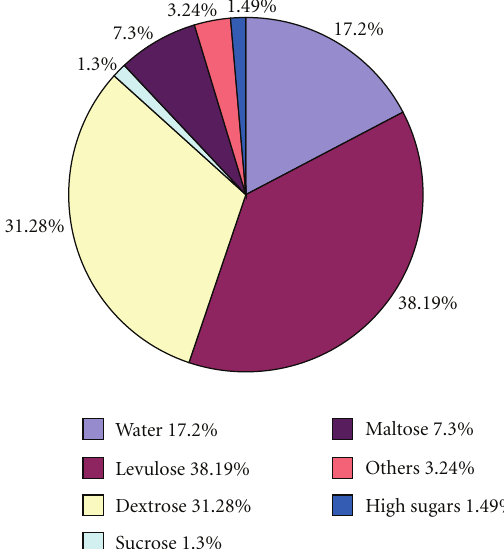
Figure 2: Pie-chart of Honey composition indicating the percent- age share of various sugars, water and other minor